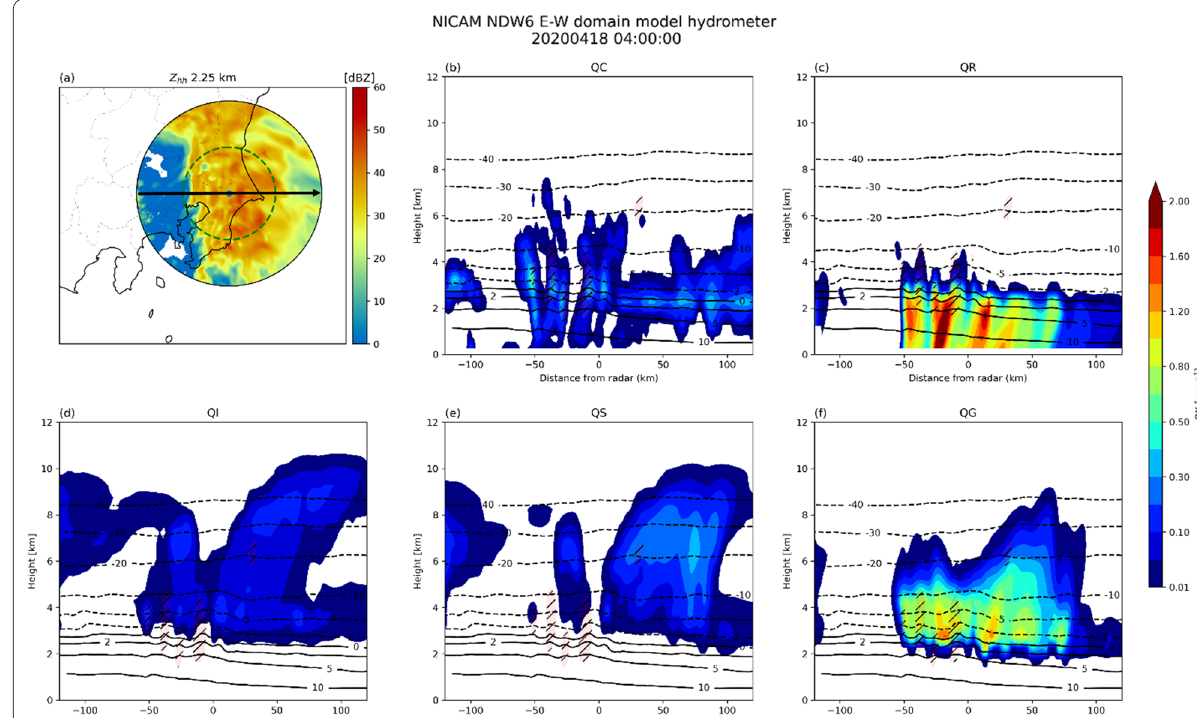
Fig. 11 The same as Fig. 10, but for the NICAM-NDW6 simulation